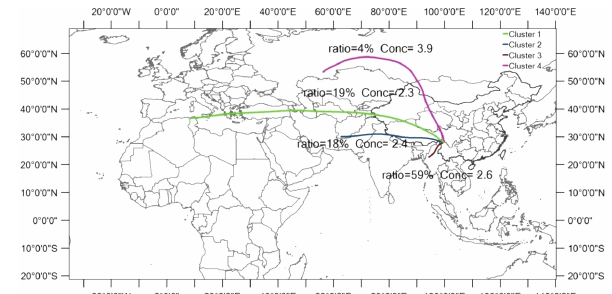
Figure 11. The back trajectories arriving at SAWRS over the study period were grouped into four clusters. Most of the air masses origi- nated from Southeast Asia (cluster 3, 59%), considerable air masses originated from North Africa and South Asia (cluster 1, 19%; clus- ter 2, 18%), only 4% of air masses originated from central Asia and Russia.